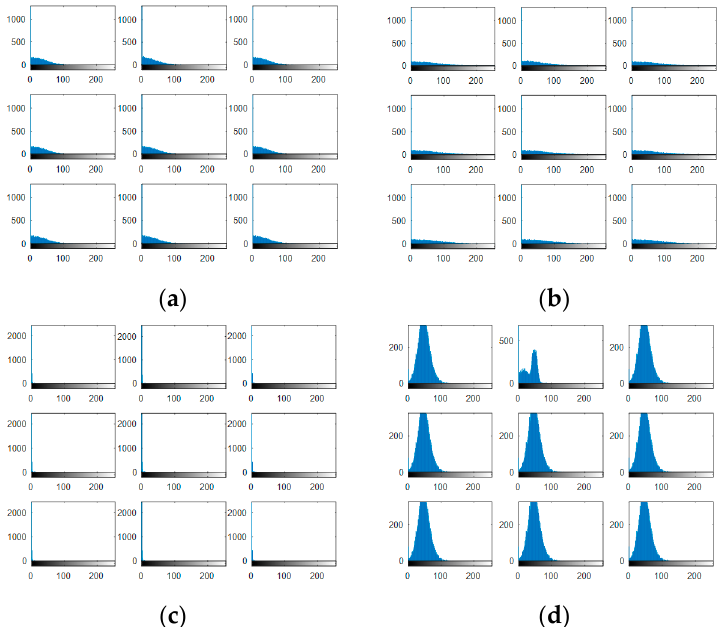
Figure 24. Histograms of encrypted images based on combinations in Figure 22, i.e., ( a ) CFR1, ( b ) CFR2, ( c ) homomorphic transform followed by salting and ( d ) homomorphic transform followed by random kernel convolution.